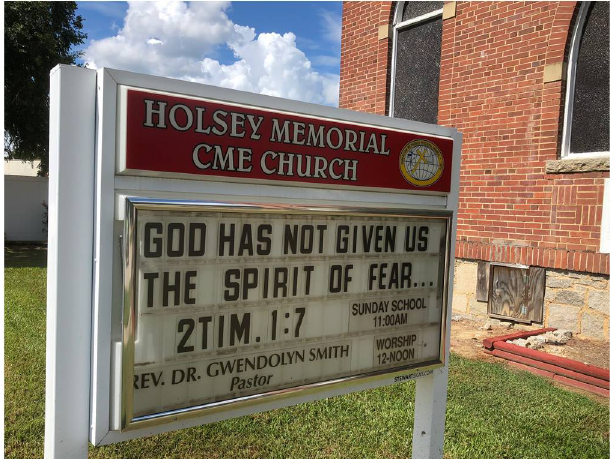
Figure 11. Holsey Memorial CME Church, formerly Ebenezer CME Church, in Sparta, Georgia where Lucious Holsey pastored after the Civil War. Photograph by Leo Braselton Gorman.